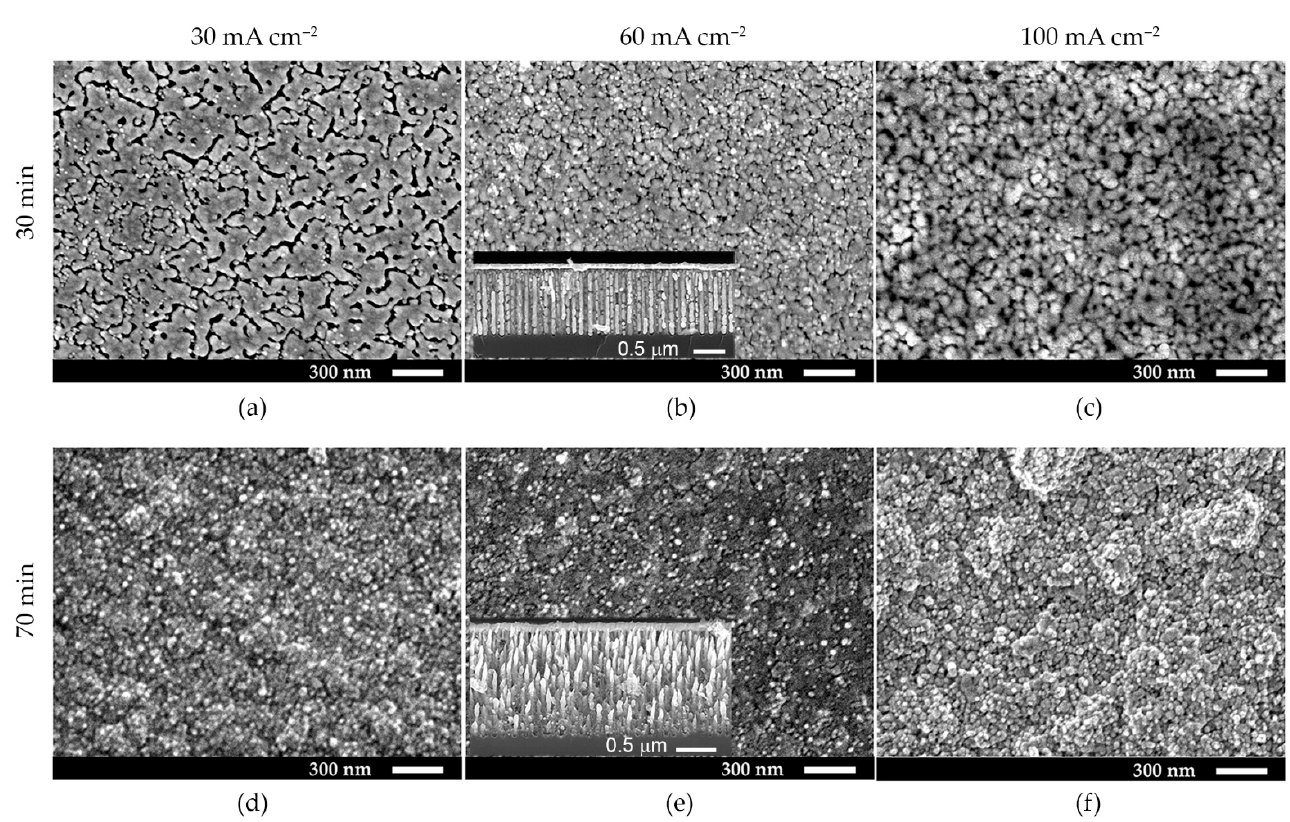
Figure 2. SEM images after Au deposition on the PS with a 49% ( a , d ), 59% ( b , e ), and 72% ( c , f ) porosity for 30 min ( a – c ) and 70 min ( d – f ). The insets in ( b , e ) depict the cross-section view for the meso-PS after the Au deposition.